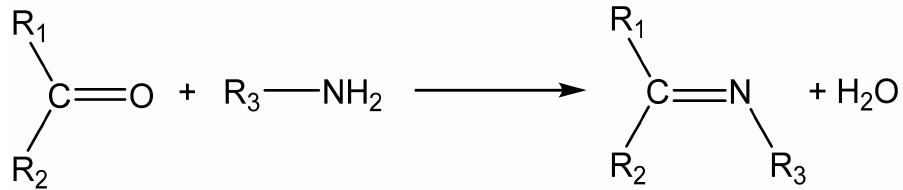
Figure 2. General scheme for the formation of Schiff bases.